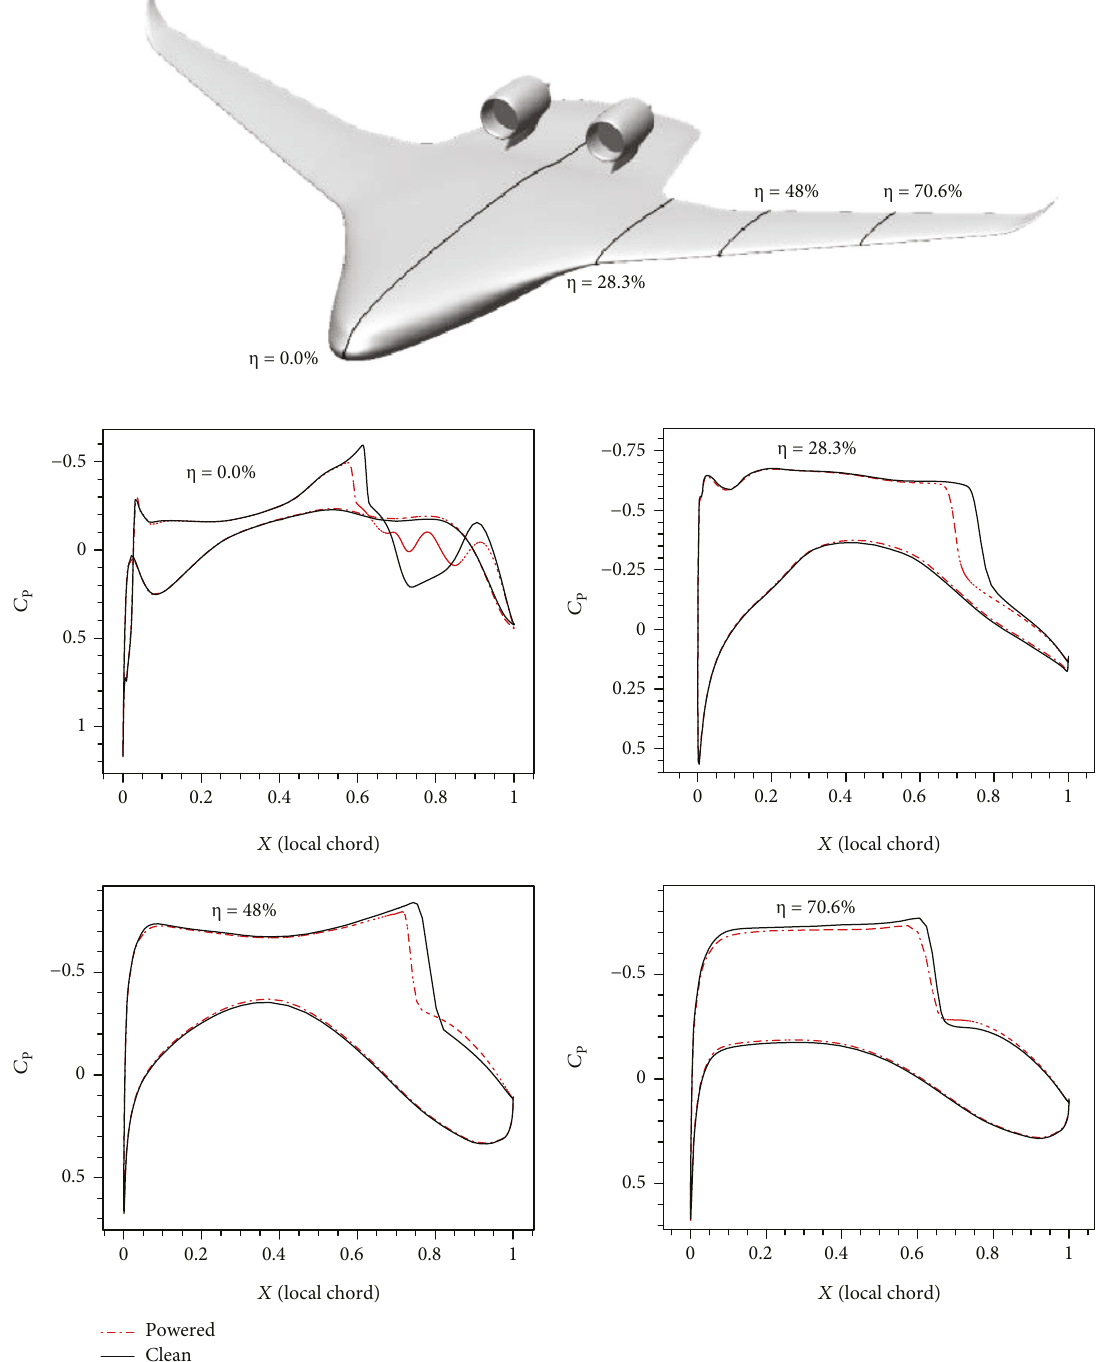
Figure 17: Pressure distribution of di ff erent spanwise sections at the cruise